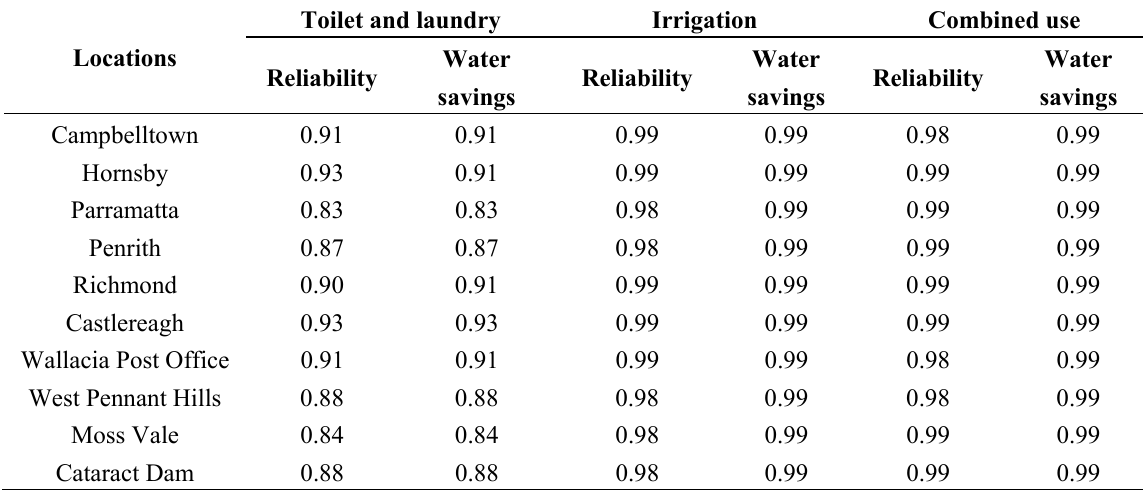
Table 2. Correlation coefficients between (i) reliability vs . tank size and (ii) water saving vs . tank